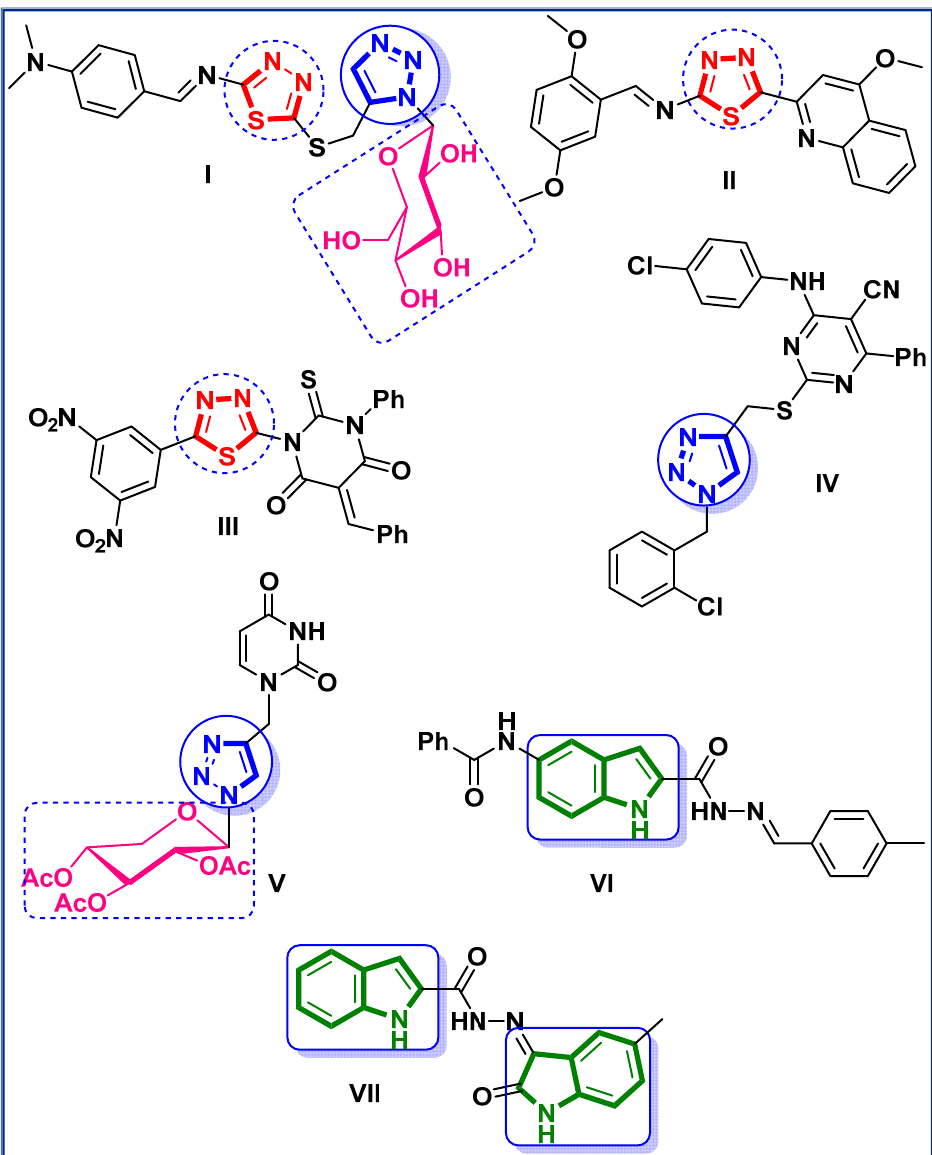
Figure 1. Reported anticancer agents bearing 1,3,4-thiadiazol, 1,2,3-triazole, indole and glycoside fragments.